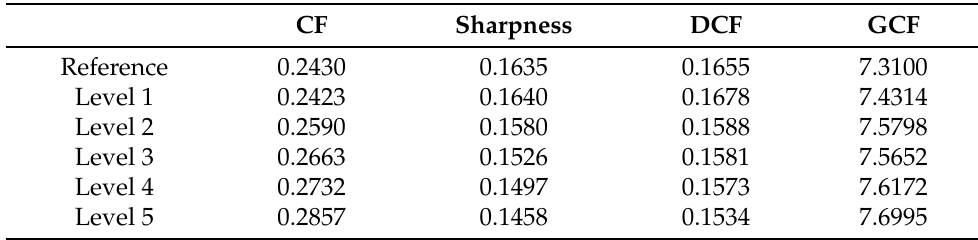
Table 3. The average values of perceptual features in the KADID-10k [46] database with respect to the five different distortion levels. Level 1 stands for the lowest level of distortion, while Level 5 denotes the highest